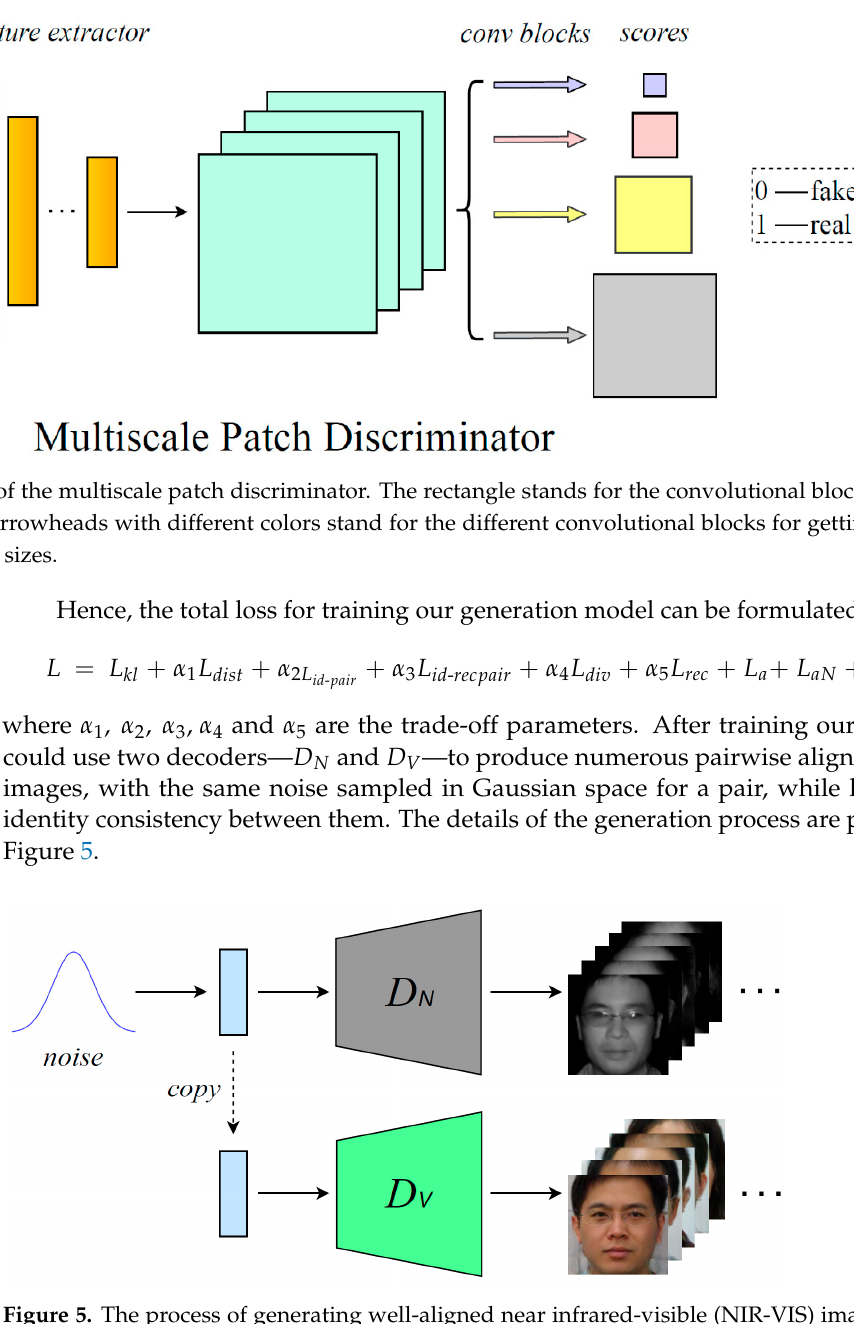
Figure 5. The process of generating well-aligned near infrared-visible (NIR-VIS) images with the same identity.